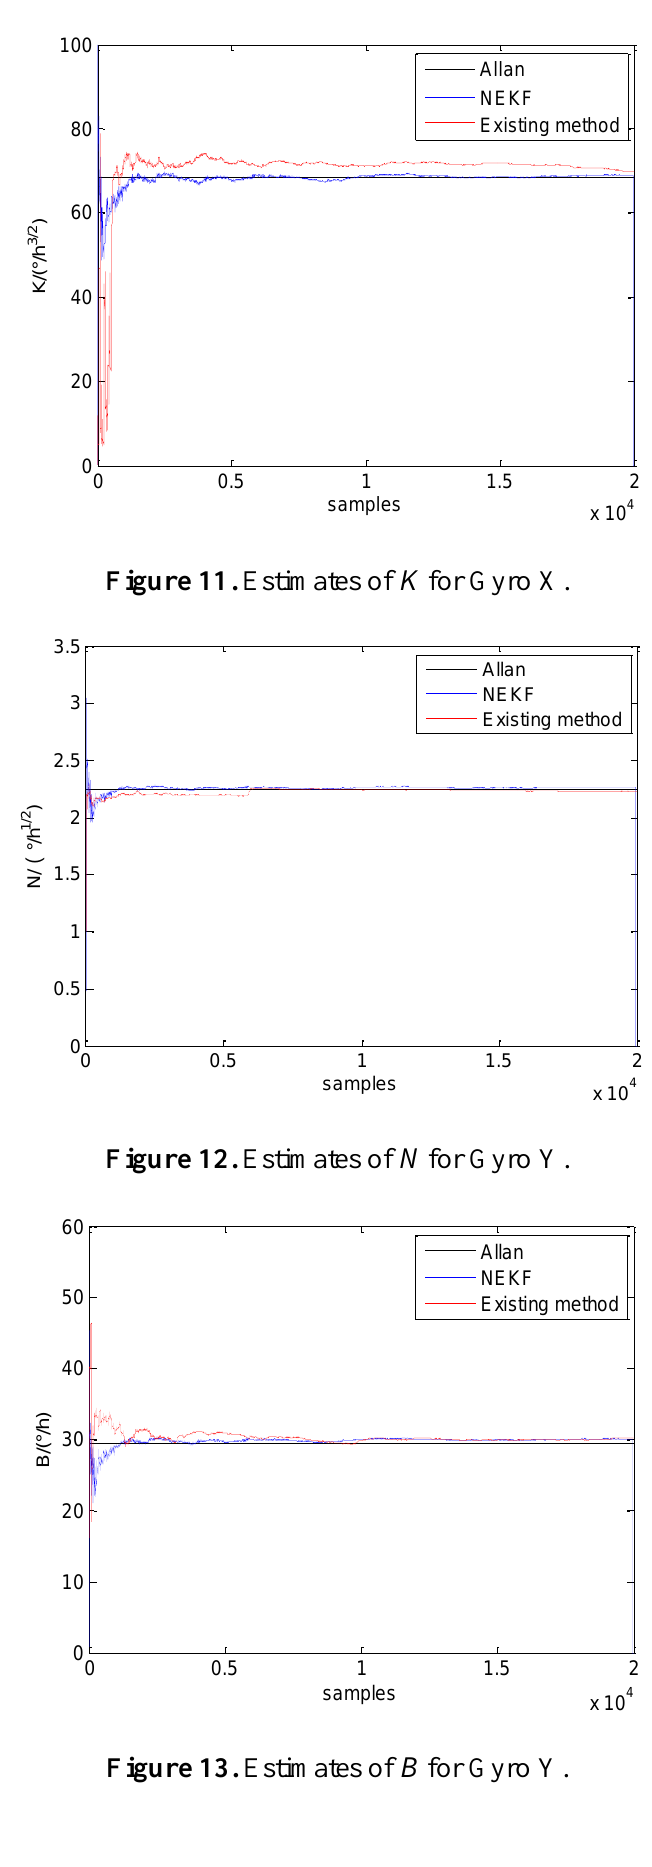
Figure 13. Estimates of B for Gyro